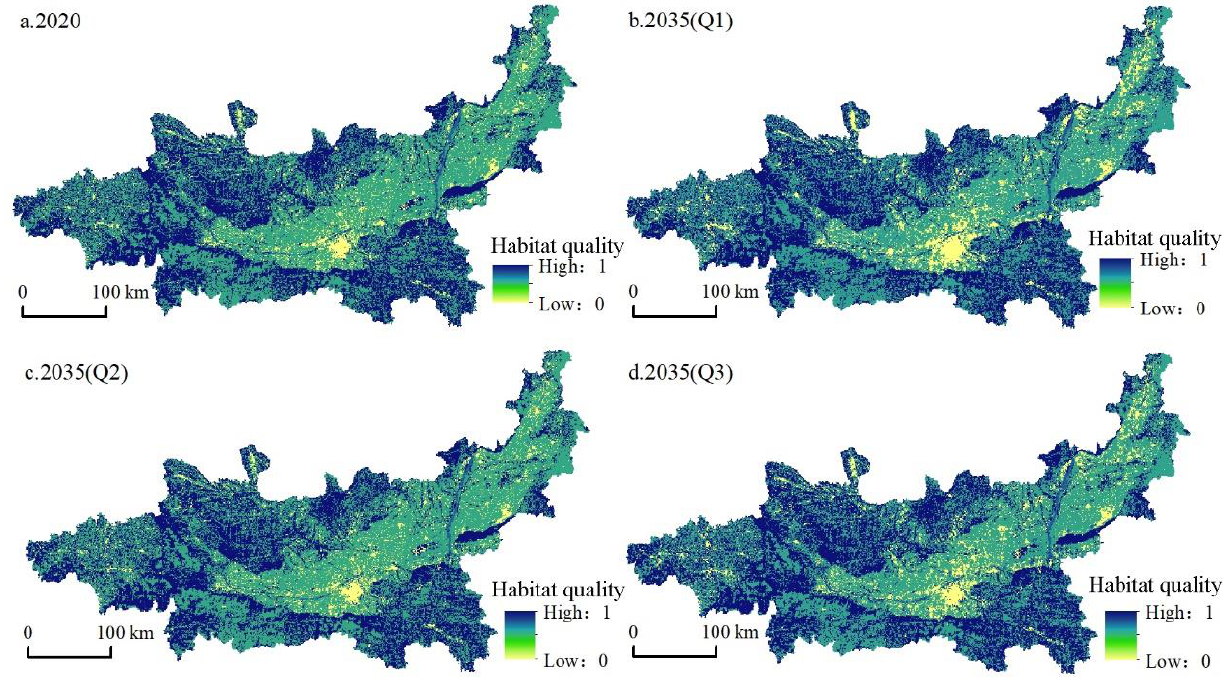
Figure 6. Spatial distribution of habitat quality in the Guanzhong Plain urban agglomeration under different scenarios in 2035.